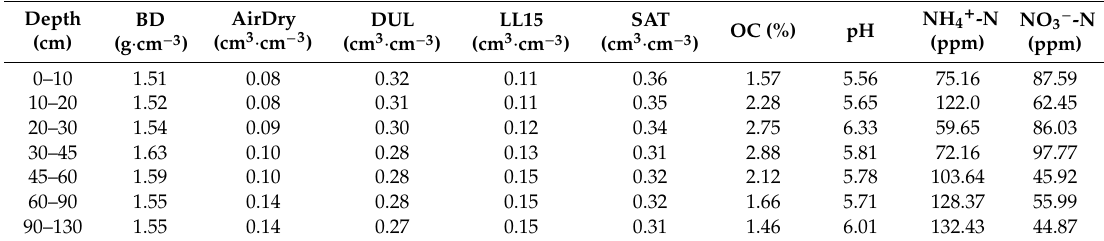
Table 6. Soil properties observed in the field